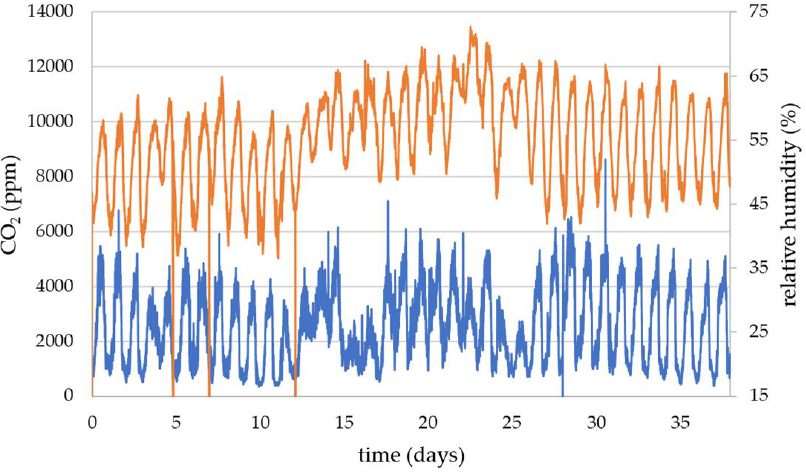
Figure 4. HPP6 queen excluder sensor comparing the CO 2 (blue data using left hand side axis) with the relative humidity (orange data using right hand axis).